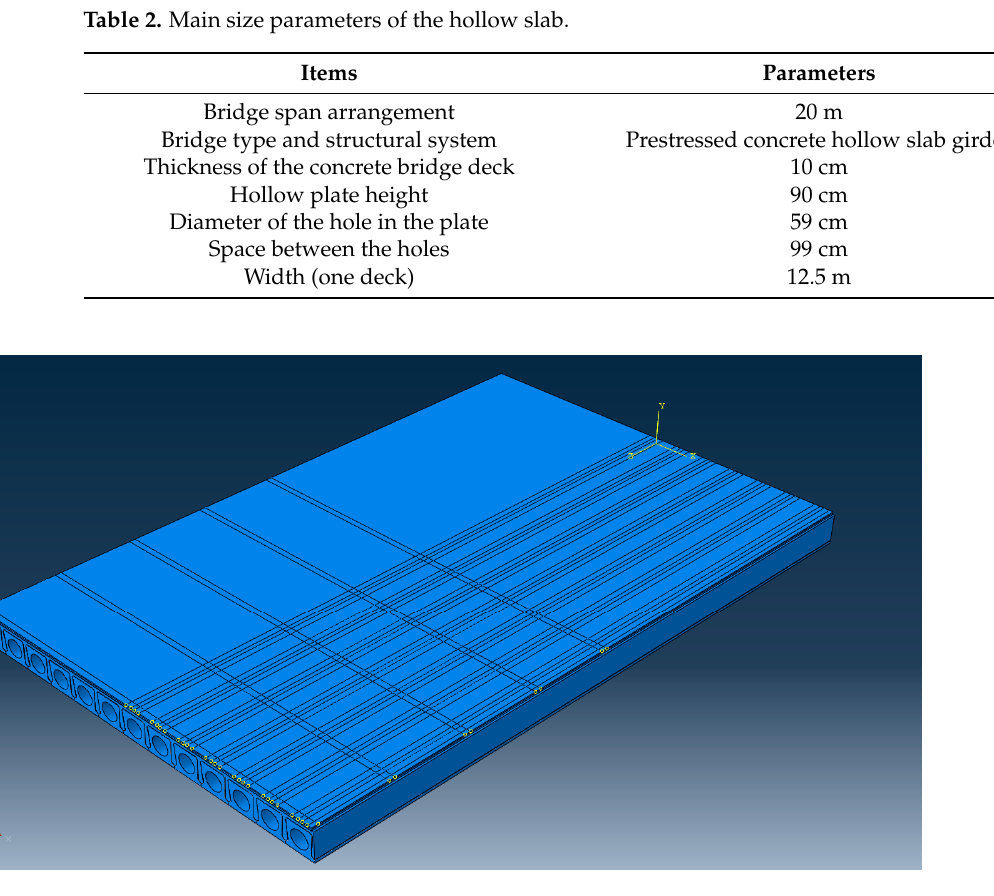
Figure 1. Structural model of the cement concrete bridge pavement. Table 3. Physical properties of the asphalt